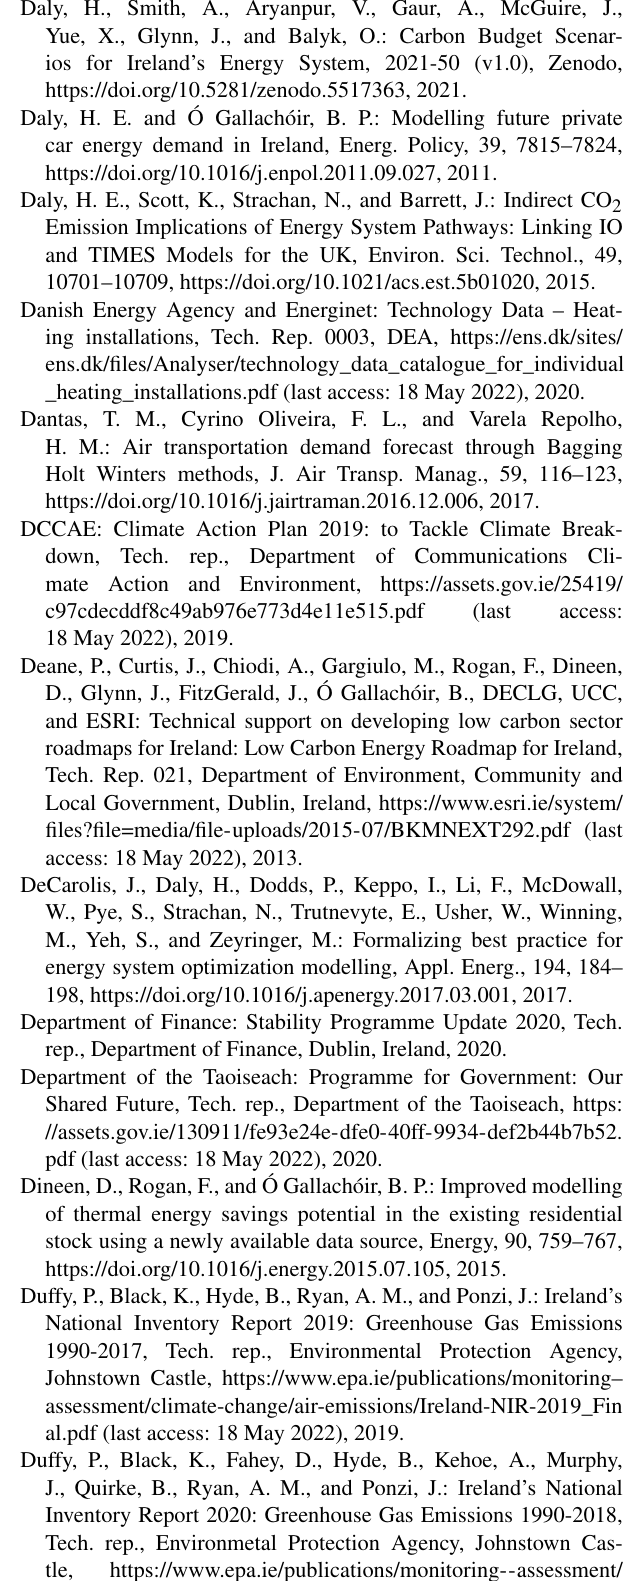
CSO: Census of Population 2016 – Profile 2 Population Distribution and Movements, Central Statistics Office (CSO), https://www.